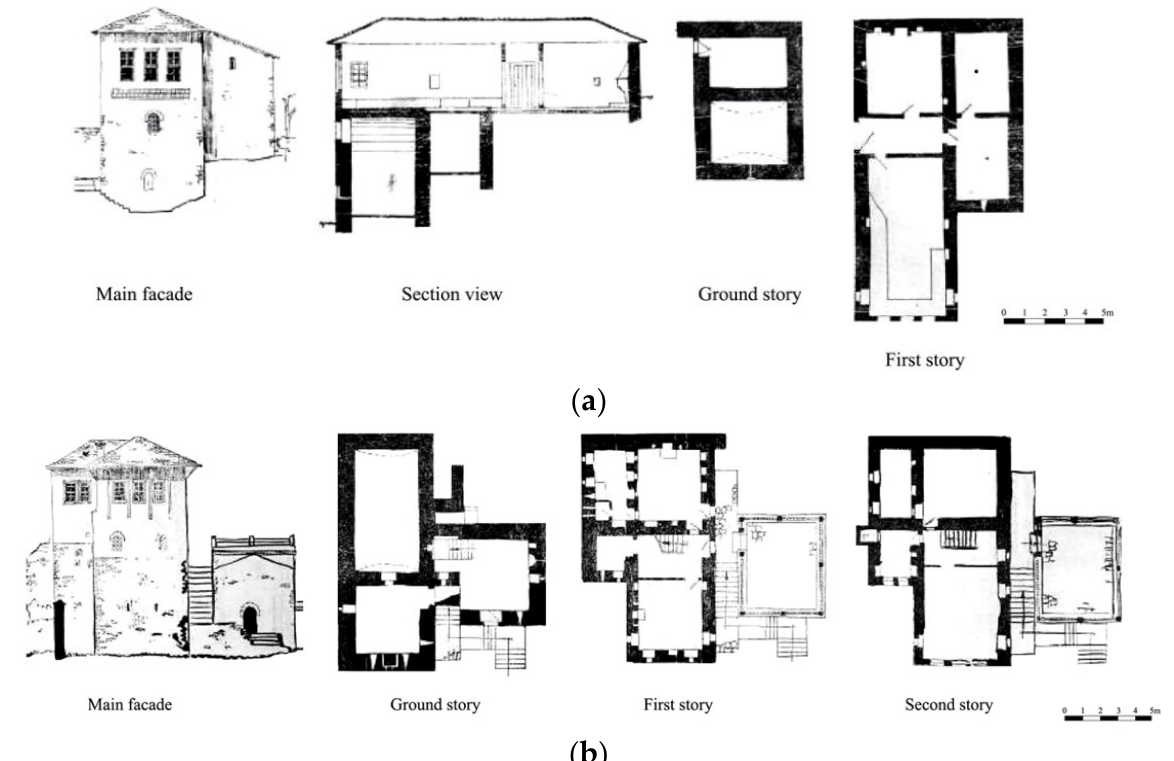
Figure 4. Examples of the perpendicular building: ( a ) two stories, ( b ) three stories (adapted from [3]).